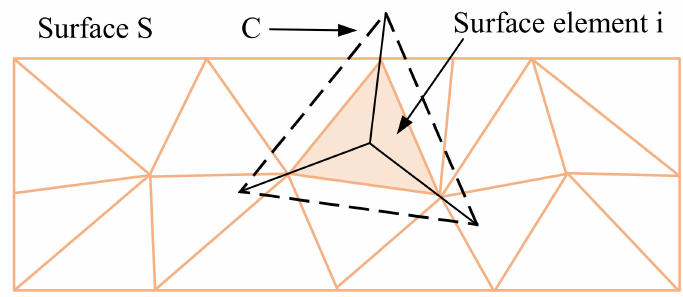
Figure 4. Calculation of discrete surface